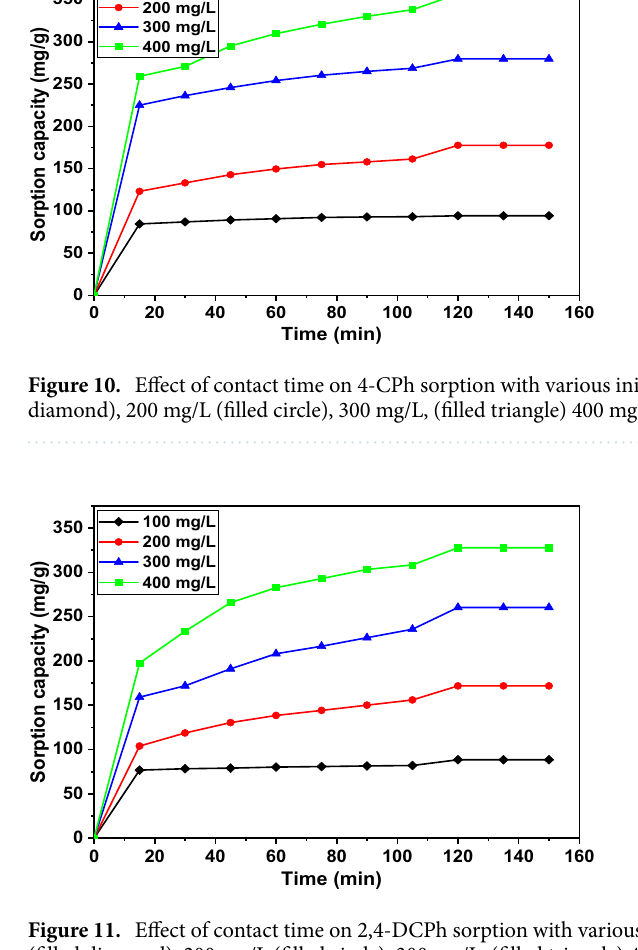
Figure 11. Effect of contact time on 2,4-DCPh sorption with various initial concentrations C 0 = 100 mg/L (filled diamond), 200 mg/L (filled circle), 300 mg/L, (filled triangle) 400 mg/L (filled